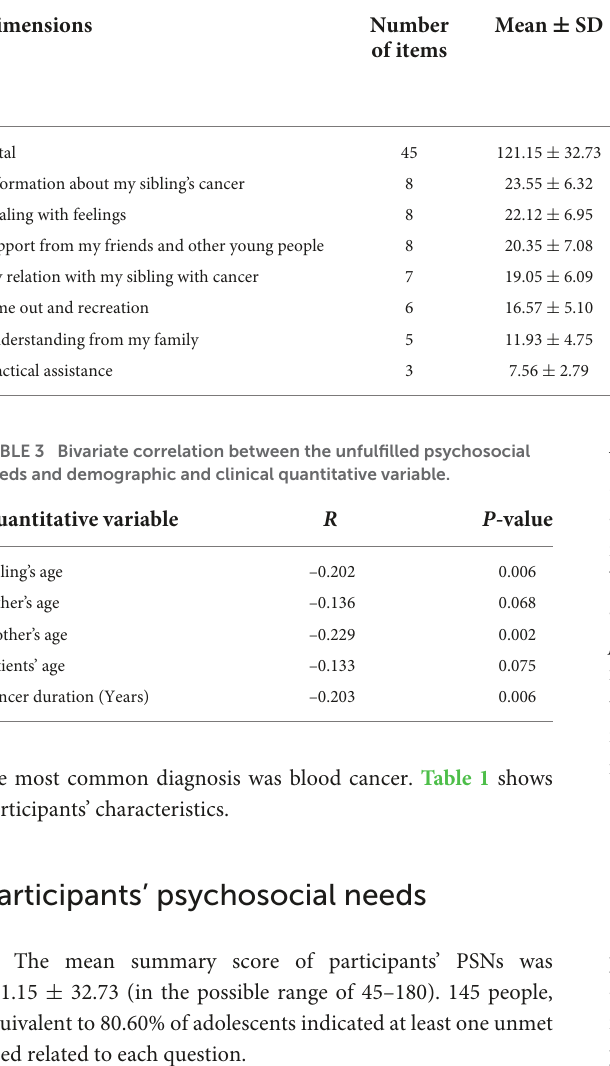
TABLE 2 The mean scores of PSNs and their dimensions. Dimensions Number